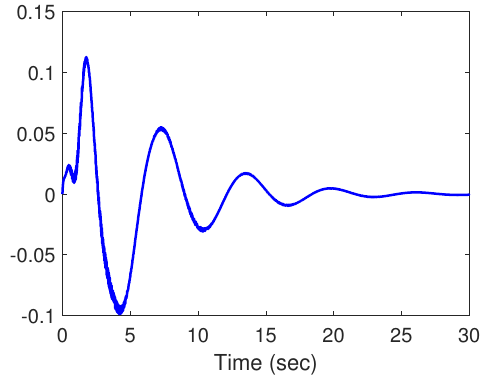
Figure 4. The trajectory of the control input u ( t )